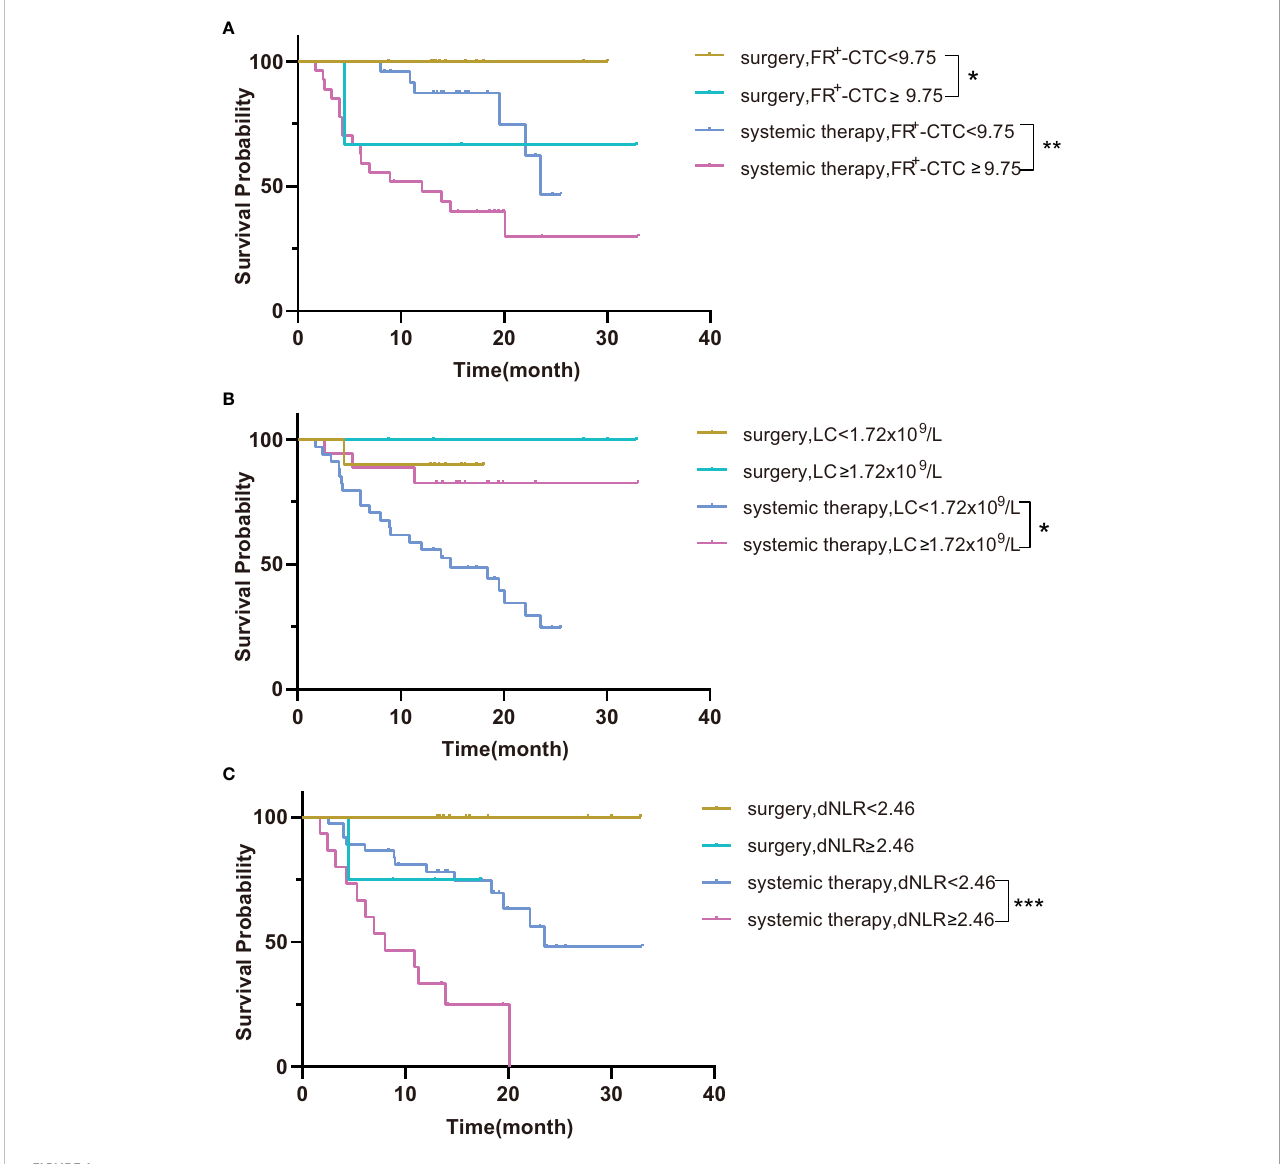
FIGURE 1 (A) Kaplan – Meier curves for survival probability according to the FR + -CTC count between surgery and systemic therapy. (B) Kaplan – Meier curves for survival probability according to the LC between surgery and systemic therapy. (C) Kaplan – Meier curves for survival probability according to the dNLR between surgery and systemic therapy. *P < 0.05, **P < 0.01, ***P <